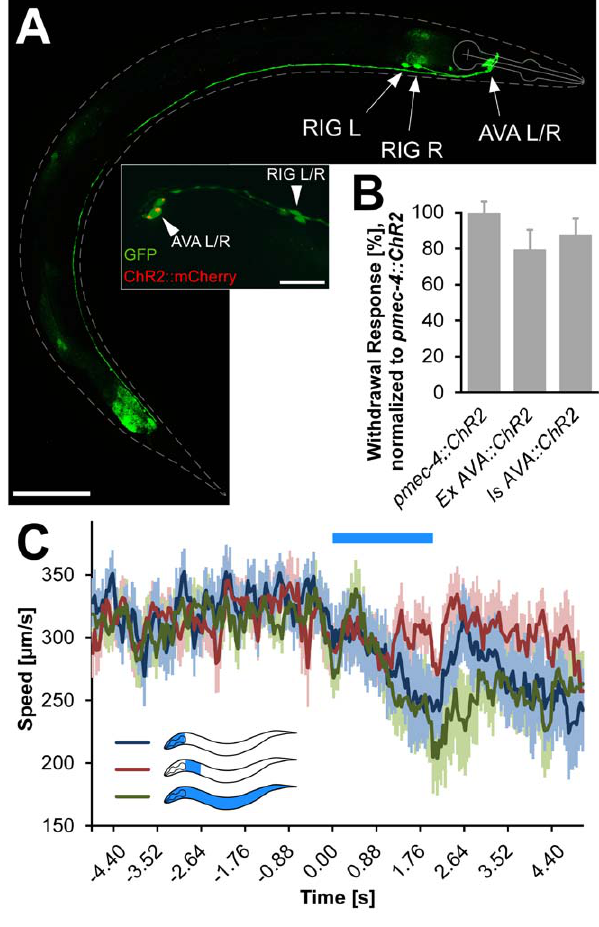
Figure 6. ChR2::mCherry::SL2::GFP expression in AVA (and RIG) neurons using flp-18 and gpa-14 promoters and Cre recombi- nase from an integrated transgene. A ) Confocal stack showing GFP fluorescence of the specific expression pattern. Scale bar=100 m m (20 m m in inset). Inset: Overlay of the ChR2::mCherry (red) and the much brighter SL2::GFP (green) expression. B ) Withdrawal in response to whole-animal blue illumination, compared in the transgenic line before (Ex) and after chromosomal integration (Is) was compared after normalization to the responses of p mec-4 ::ChR2 animals tested alongside. C ) Locomotion speed traces of animals of the integrated strain expressing ChR2 in AVA (and RIG) before, during and after patterned illumination of either of two different segments in the head region (blue, segment harboring AVA cell bodies; red, segment harboring RIG cell bodies, and parts of the AVA axons). In addition, the whole animal was illuminated (green). Displayed are means 6 SEM (n $ 15 in B and C). Duration of the light stimulus is indicated by a blue bar.